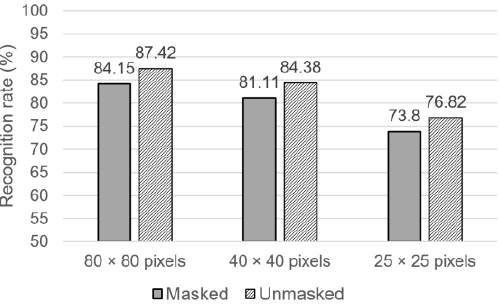
Figure 9. Recognition rates for different facial resolutions. The recognition rates measured for unmasked face images were also present for comparison.